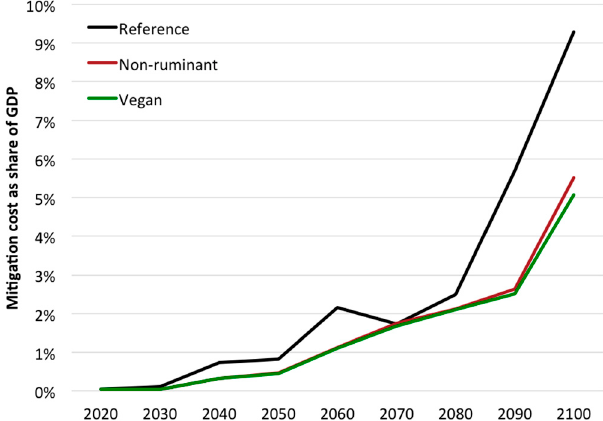
Figure 5. Mitigation costs for the energy system as share of GDP over time.